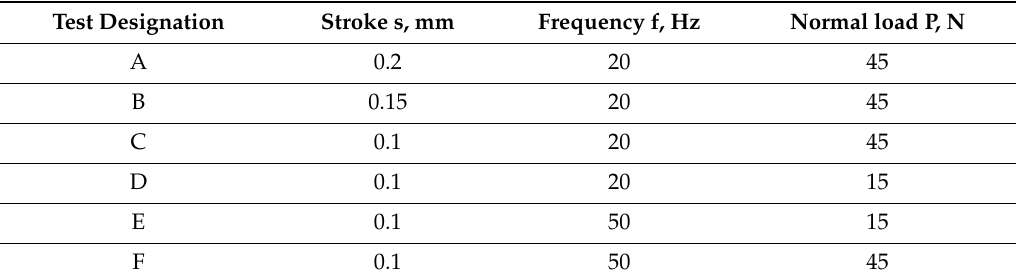
Table 1. Experimental conditions of gross sliding fretting